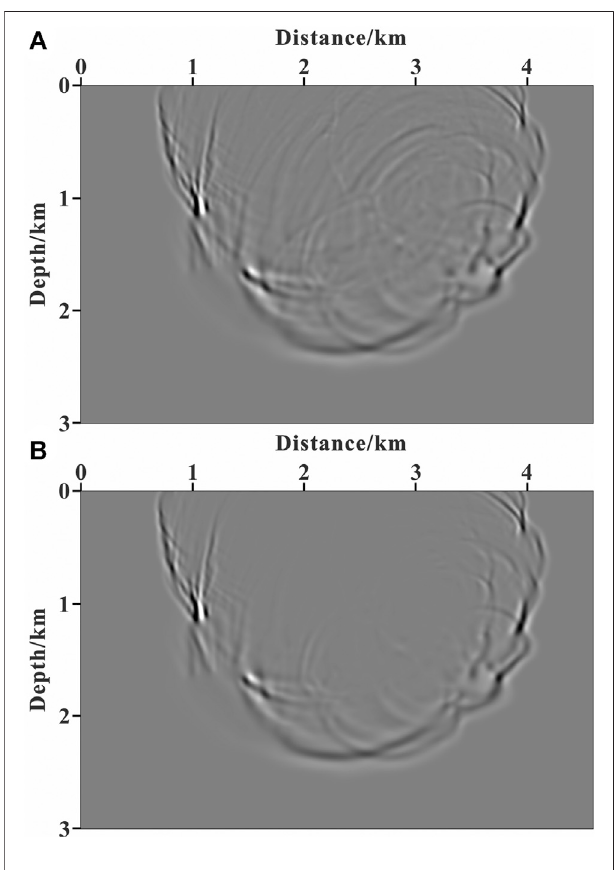
FIGURE 3 | Wavefront snapshots of numeric modeling at 1.05 s: (A) based on the acoustic wave equation; (B) based on the non-re fl ecting acoustic wave